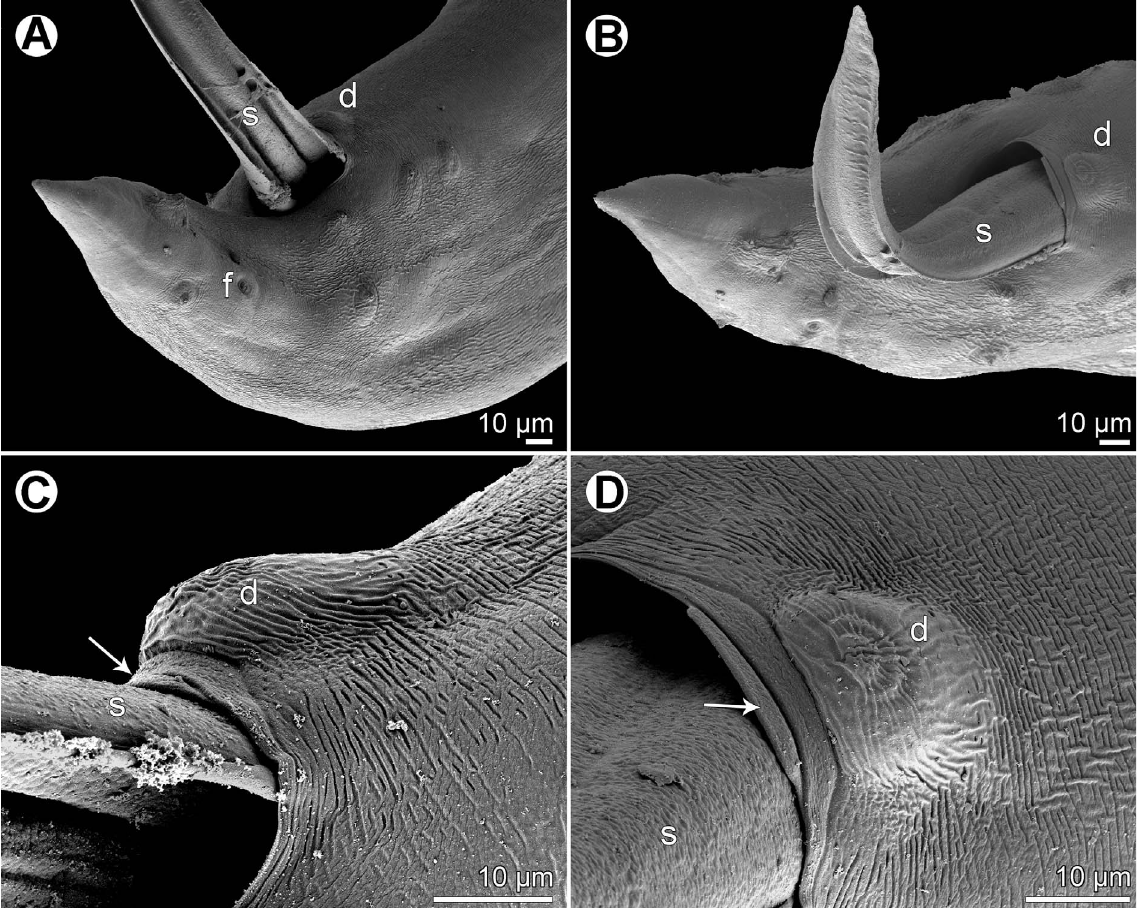
Figure 6. Cucullanus gymnothoracis n. sp., scanning electron micrographs of male. (A, B) Tail, lateral and ventral views, respectively; (C, D) precloacal region, lateral and ventral views, respectively (arrows indicate outgrowth of anterior cloacal lip). (d) median precloacal papilla-like formation; (f) phasmid; (s)